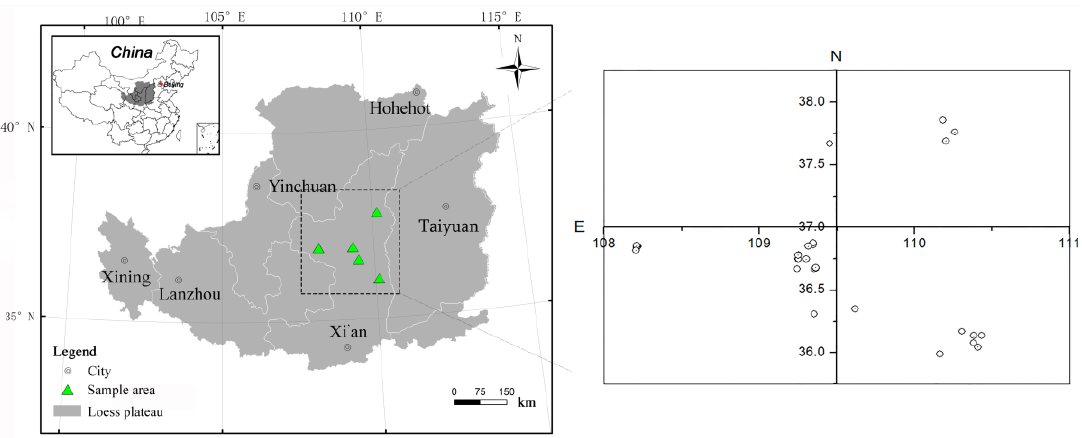
Figure 1. Location of the study sites in the center of the Loess Plateau,